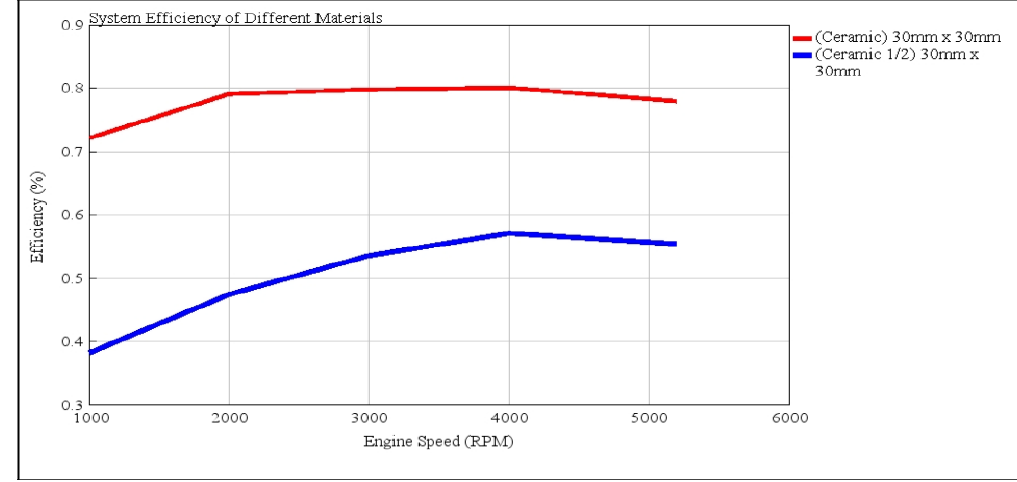
Figure 20. System efficiency of different materials (1 module).